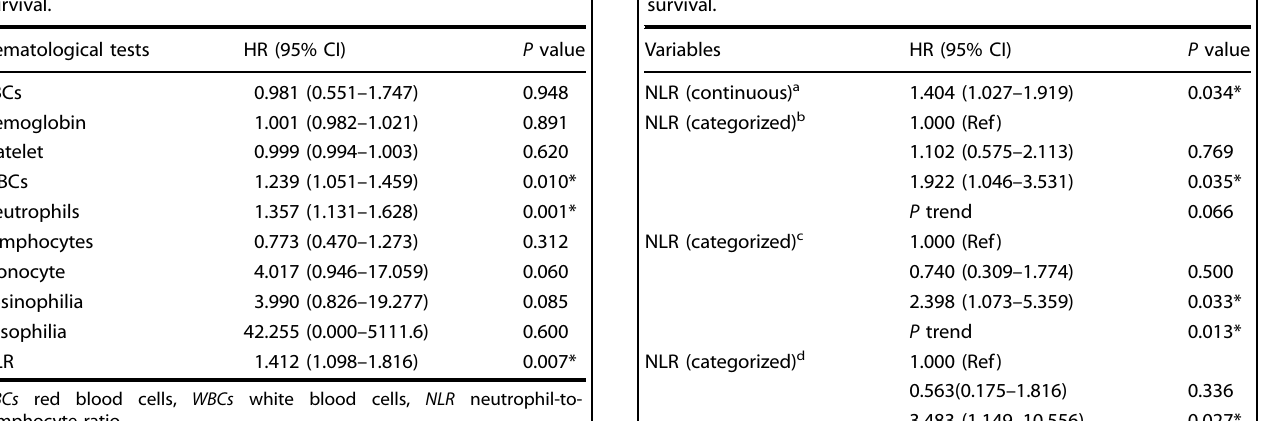
*Signi fi cant difference after adjusting by false discovery rate.